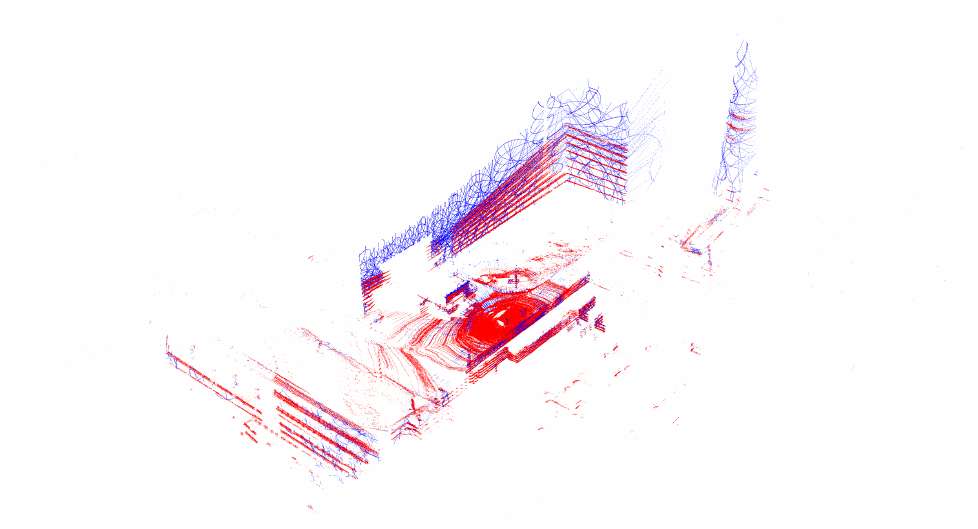
Figure 9. Undistorted, aggregated point clouds were built using data from the Livox Mid–40 with the rotated reflector (blue) and Velodyne VLP 16 (red) at Zwentendorf NPP. It is important to notice that our system has a larger field of view. Note the non repetitive scanning pattern produced by the rotating reflector.